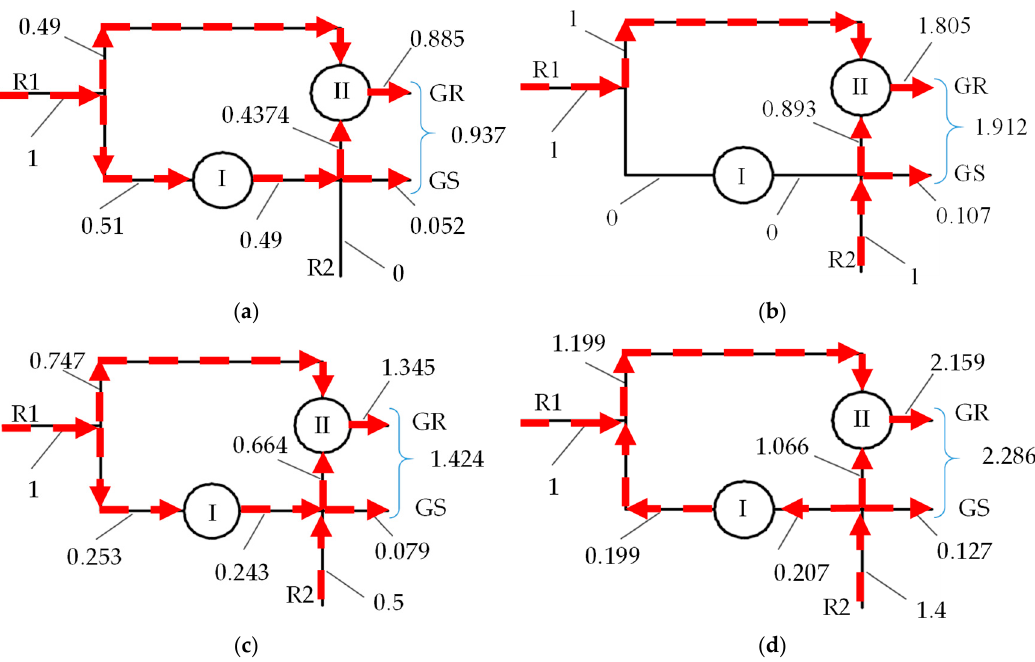
Figure 7. Power flow in the premise of considering friction for the case: (a) k t = 0; (b) k t = 1; (c) k t = 0.5 (< 1); (d) k t = 1.4 (> 1 ) .